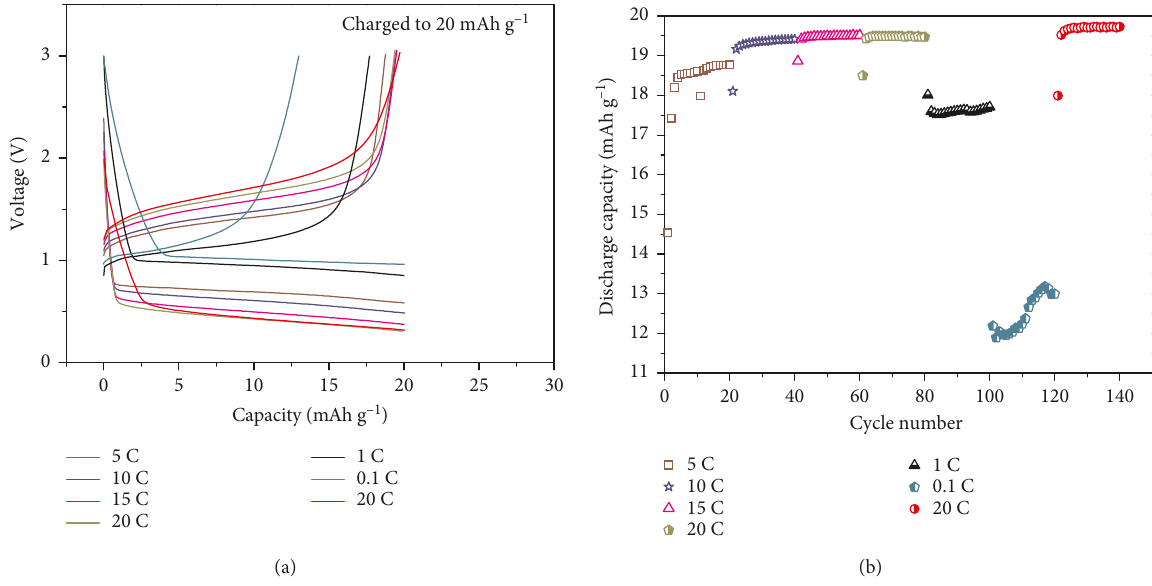
LiClO 4 /PC, with the cell charged to ·